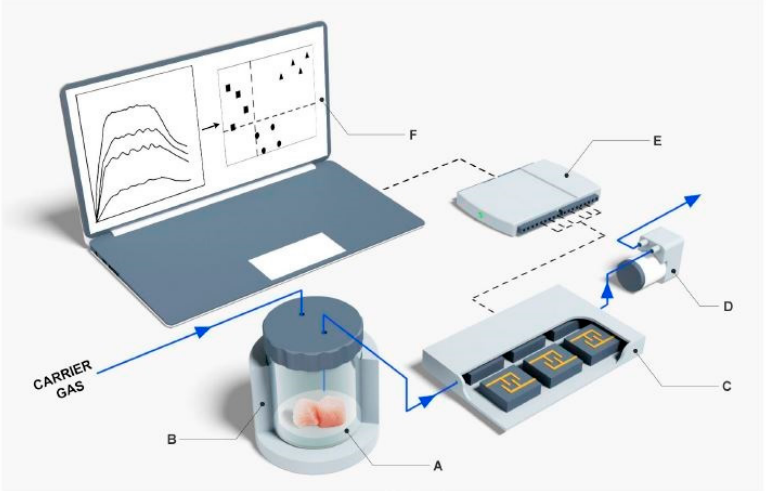
Figure 6. Schematic diagram of the main components of e ‐ nose [147] .